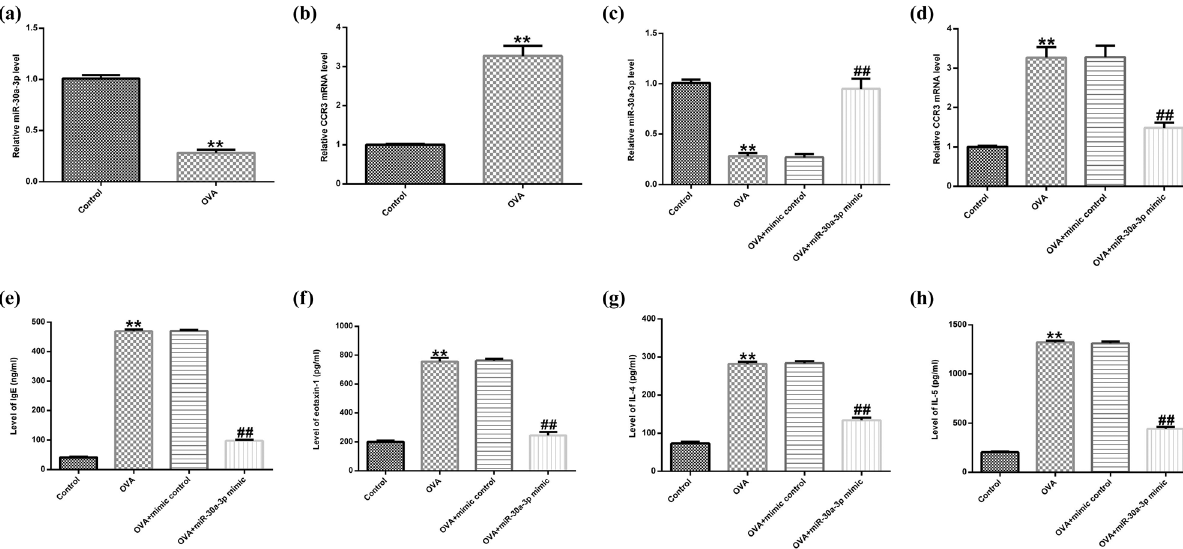
Figure 3: MiR - 30a - 3p decreases the expression of chemokines and Th2 cytokines. ( a and c ) The expression of miR - 30a - 3p was determined using qRT - PCR. ( b and d ) The CCR3 gene expression in di ff erent groups was determined using qRT - PCR. The secretion levels of ( e ) OVA - speci fi c IgE, ( f ) IL - 4, ( g ) IL - 5 and ( h ) eotaxin - 1 were determined using ELISA assay. Th2, type 2; CCR3, CC chemokine receptor 3; OVA, ovalbumin.